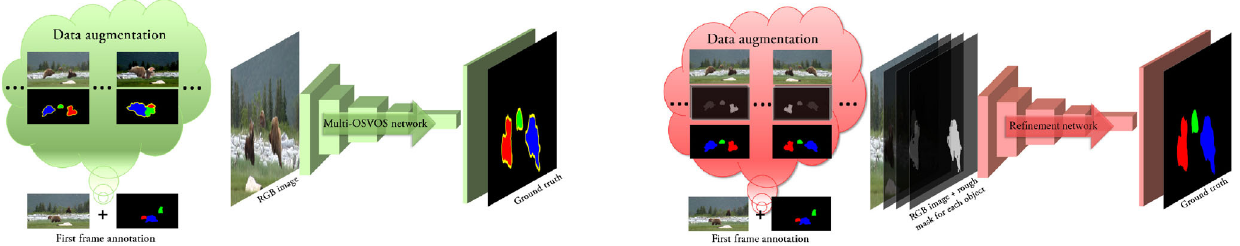
Fig. 2 Two networks used in the general pipeline. Left: multi-OSVOS network, right: refinement network. They serve different purposes: the multi-OSVOS network helps us separating background and objects while the refinement network is used to fine-tune a rough input mask.